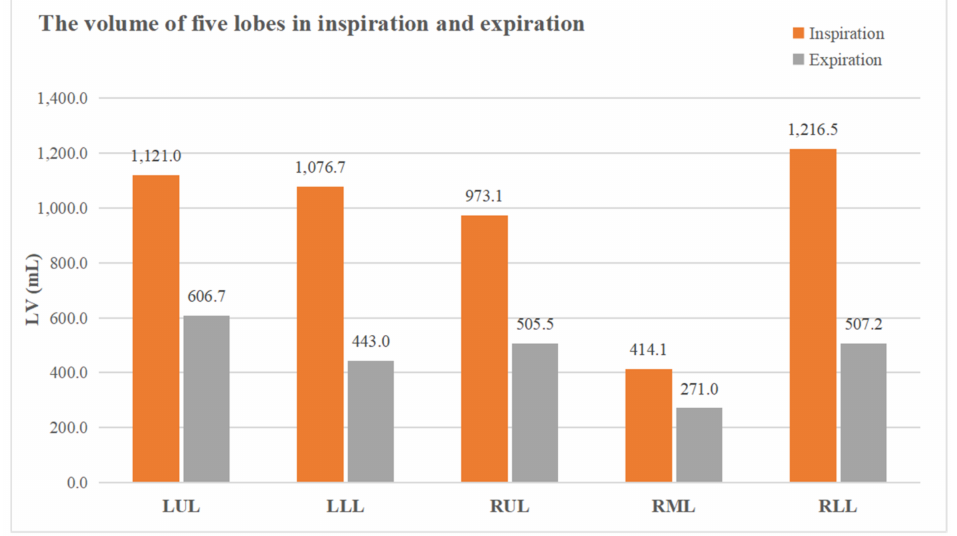
Figure 4. The lobar volume measured by paired inspiratory–expiratory chest